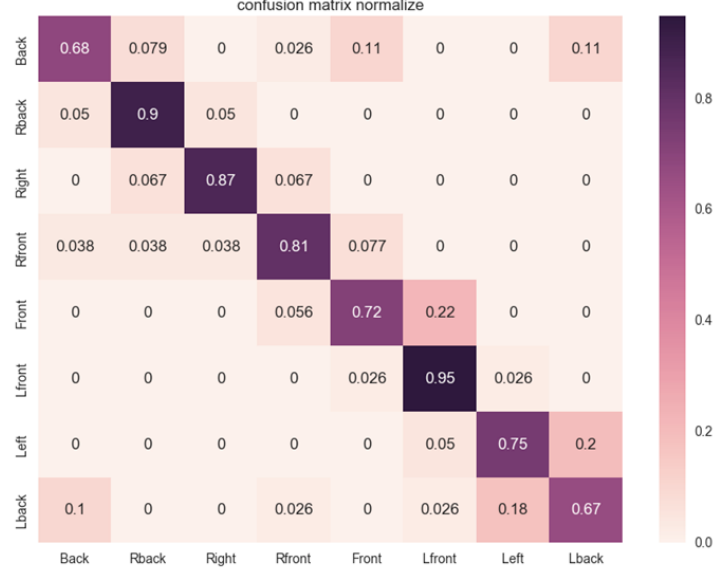
Figure 3. Confusion matrix based on accuracy (ACC) of proposed method (%).